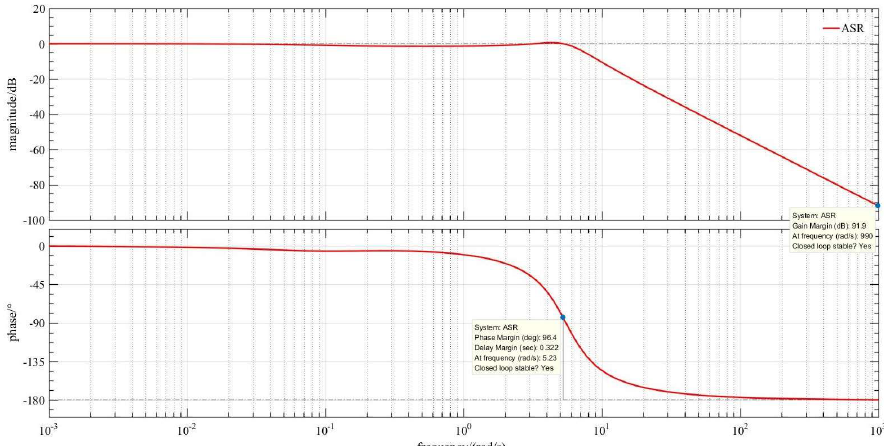
Figure 12. Bode diagram of double closed-loop control system.